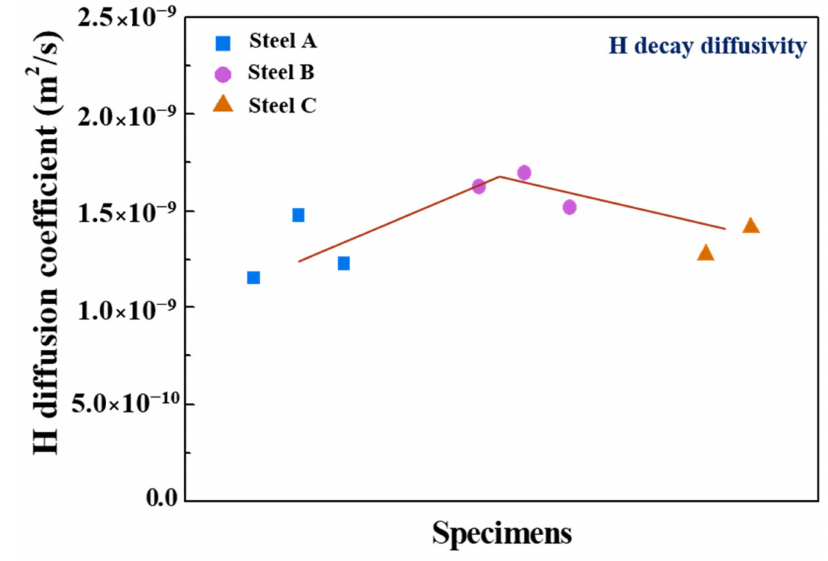
Figure 6. Hydrogen di ff usion coe ffi cients obtained by curve fitting to decay permeation curves.